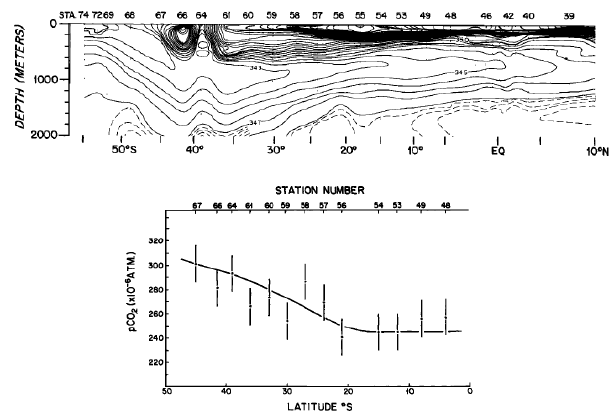
Figure 7. From Brewer (1978). The first attempt at recovering the fossil fuel CO 2 Fig. 7. From Brewer (1978). The first attempt at recovering the fos- signal by direct measurement of water masses. The data were obtained during sil fuel CO 2 signal by direct measurement of water masses. The data the Geosecs Atlantic cruise in 1972. Upper panel: A section through the well were obtained during the Geosecs Atlantic cruise in 1972. Upper defined salinity minimum of the Antarctic intermediate water. Lower panel: The estimated original pCO 2 of the water mass after correction for sub-surface panel: a section through the well-defined salinity minimum of the changes in TCO 2 from respiration, and alkalinity changes from carbonate Antarctic intermediate water. Lower panel: the estimated original dissolution and nitrate regeneration. The trend in initial pCO 2 from the recent (far p CO 2 of the water mass after correction for sub-surface changes in left) to older (far right) waters closely follows the known 20 th century trend. t CO 2 from respiration, and alkalinity changes from carbonate dis- solution and nitrate regeneration. The trend in initial p CO 2 from the recent (far left) to older (far right) waters closely follows the known 20th century